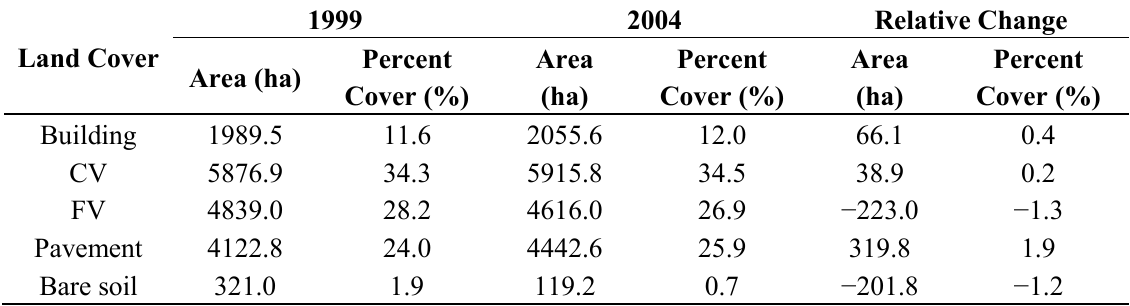
Table 4. Area and percent cover of the five land cover features in the Gwynns Falls watershed in 1999 and 2004, and their changes between the two years. Land Cover